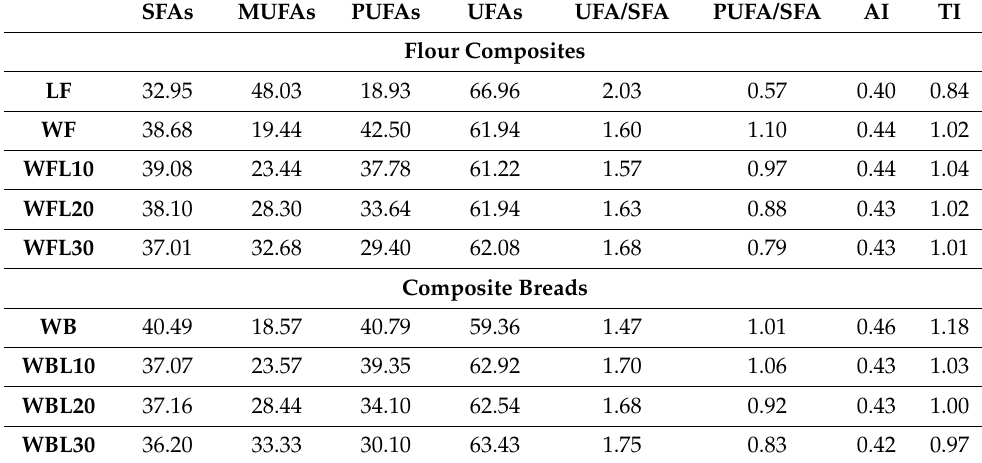
Table 7. Fatty acid classes (% of total fatty acids) fatty acid ratio and quality indices, IA and IT. SFAs MUFAs PUFAs UFAs UFA/SFA PUFA/SFA AI TI Flour Composites LF